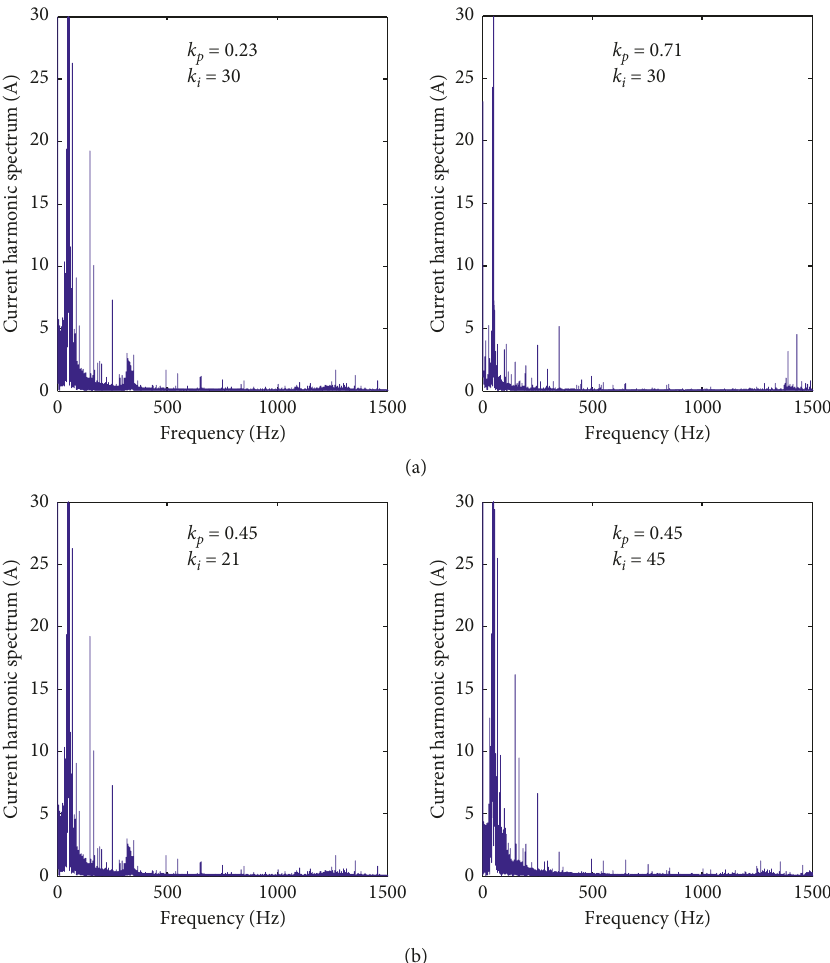
Figure 17: (a) Voltage waveform and harmonic spectrum and (b) current waveform and harmonic spectrum of the DFIG at PCC.